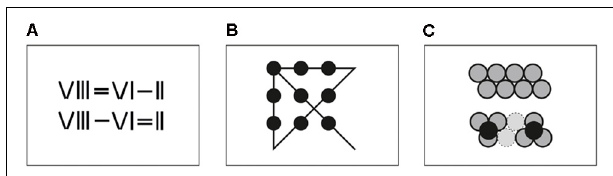
FIGURE 1 | Schematic illustration of the three tasks used to investigate the process of insight problem solving. (A) Matchstick arithmetics: Here the mathematical expression depicted in the first line has to be transformed to a correct mathematical expression by moving matchsticks around. (B) Nine-dot problem: In this task, participants have to connect the nine dots with four straight lines without lifting the pen from the paper. (C) Eight-coin problem: Here, the eight coins in the first row have to be moved in a way that each coin touches exactly three other